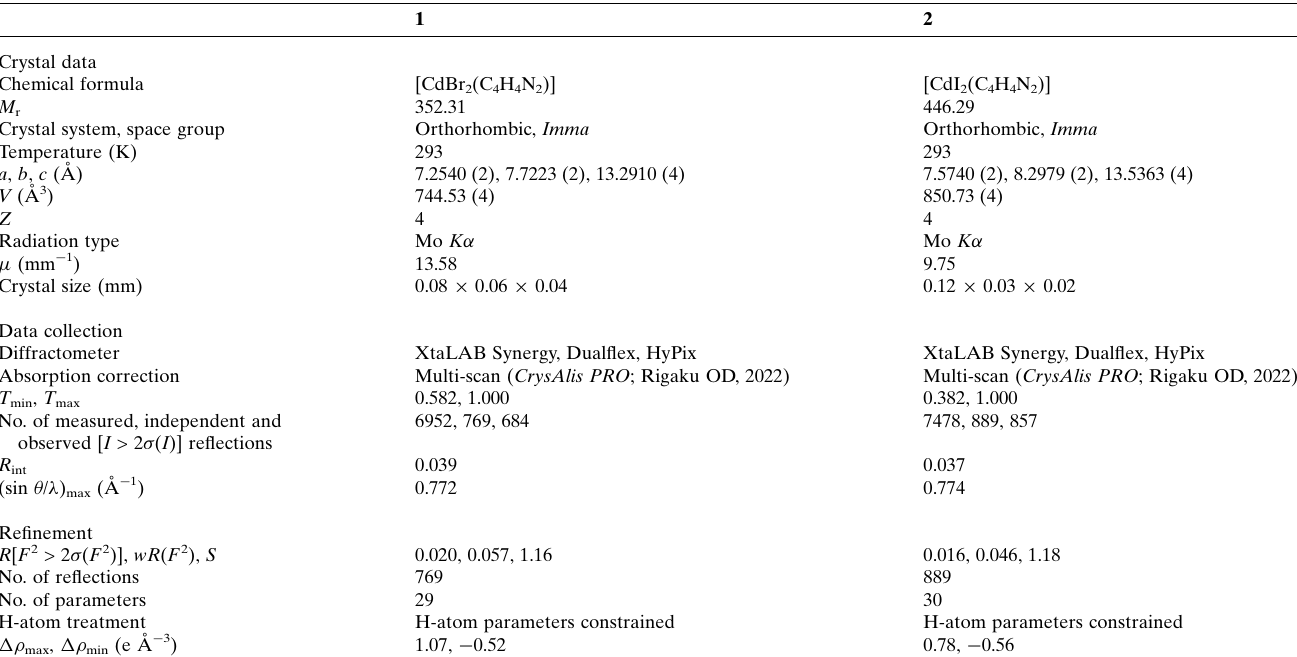
Table 3 Experimental details.